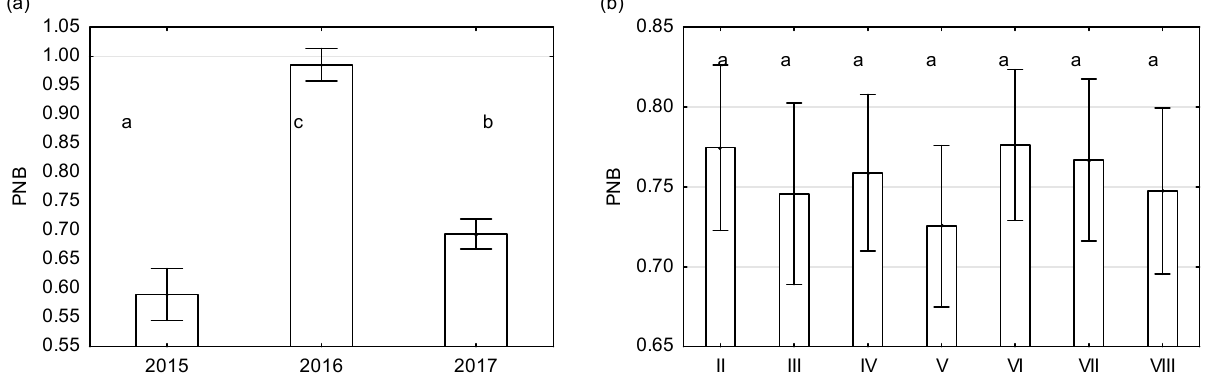
Figure 8. Partial nitrogen balance (PNB) depending on the years of the experiment ( a ) and applied fertilization ( b )—(mean ± SE; data marked with same letters do not differ significantly at p < 0.05; figure ( a ) years of experiment (2015, 2016 and 2017), figure ( b ) number of object (II–VIII)—see Table 1. Based on the results, significant relationships of NUE indicators with maize grain yields were determined (Table 5). The PNB was most strongly correlated with maize grain yield (r = 0.91 **). The correlations with grain yields determined for R N and AE were only slightly less strong (r = 0.84 ** and r = 0.83 **, respectively). A positive correlation was also detected for RIE (r = 0.42 **). On the other hand, the share of grain in nitrogen accumulation (HI N ) and PE were significantly negatively correlated with maize grain yield (r = − 0.72 ** and r = − 0.35 **,